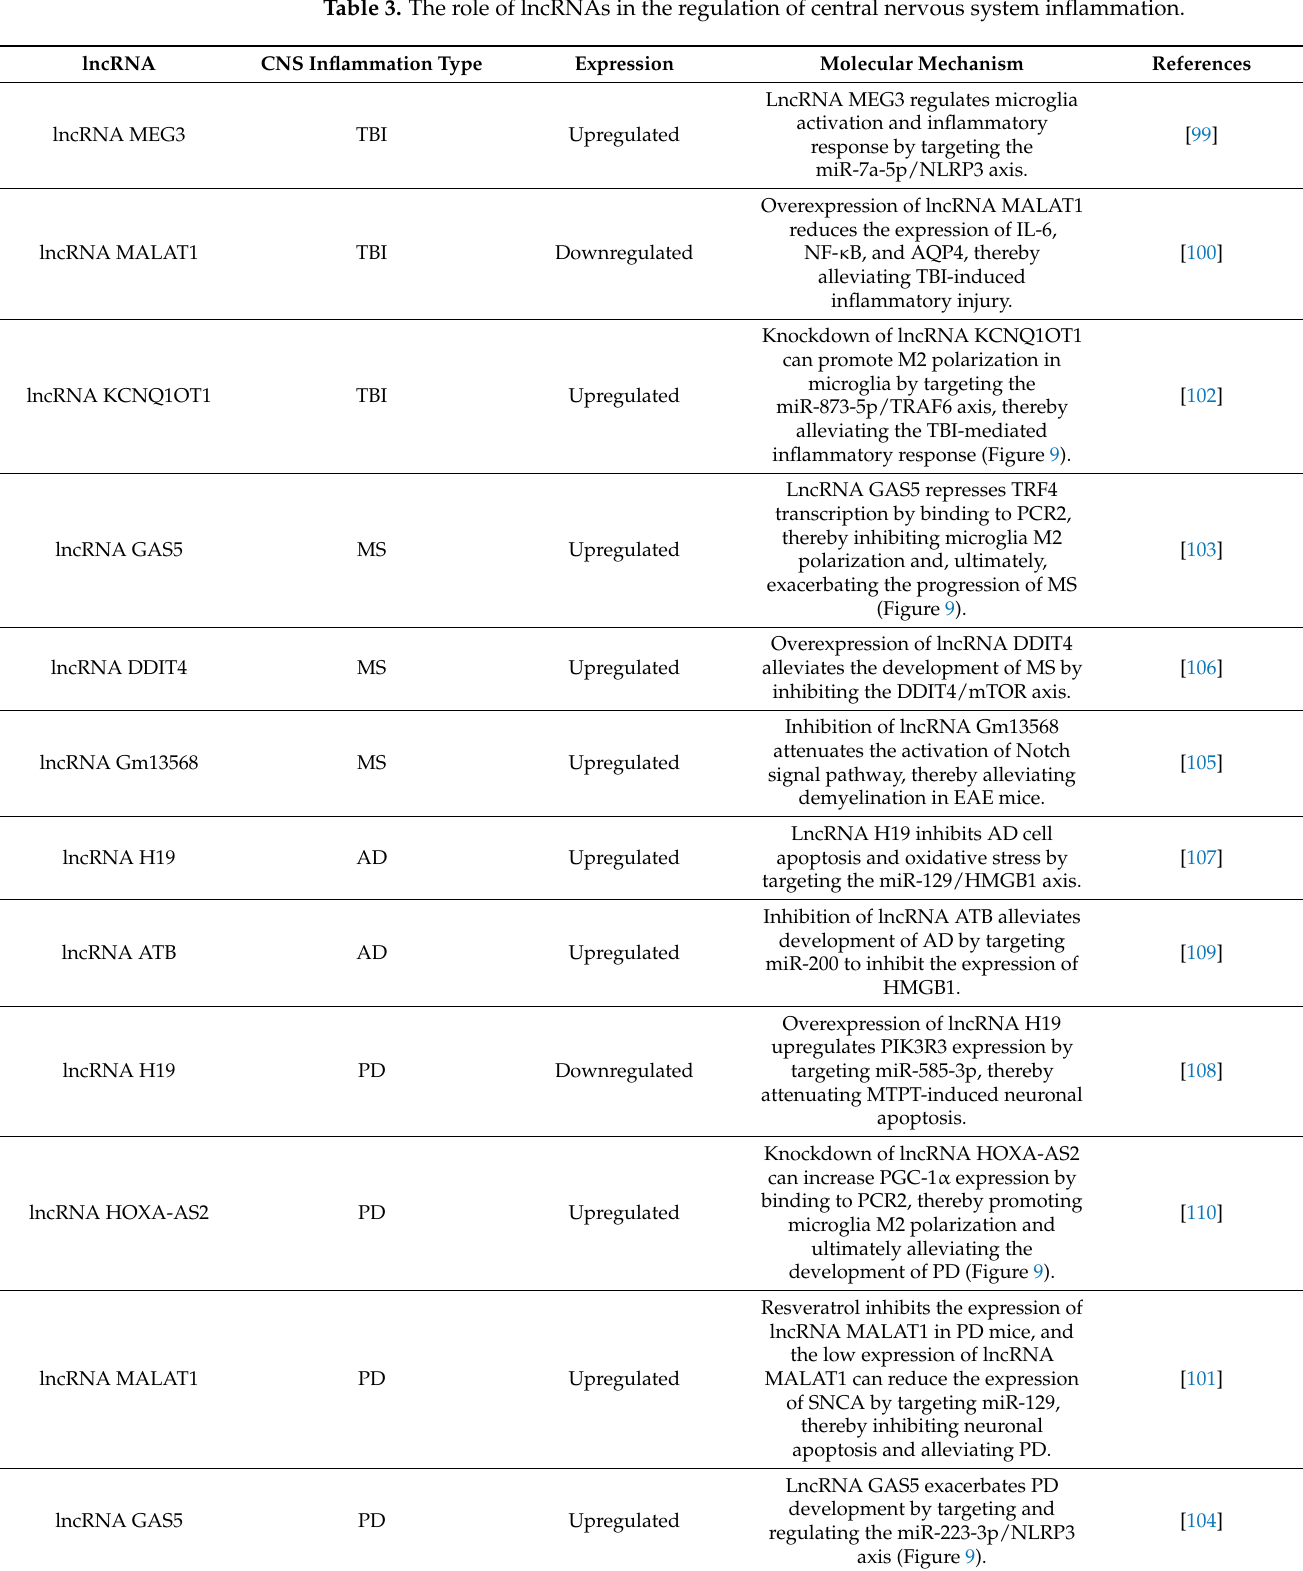
Table 3. The role of lncRNAs in the regulation of central nervous system